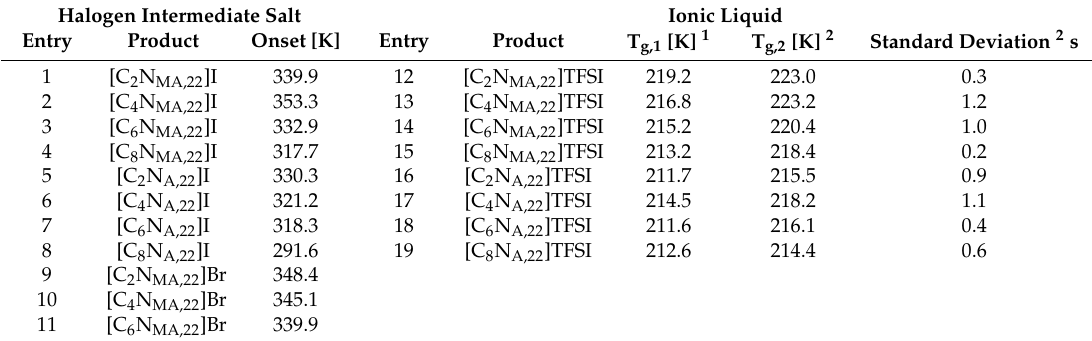
Table 4. Melting points ( T m ) and glass transition temperatures ( T g ) of the products. Standard uncertainties u for values from this work are u ( T m ) = 2 K; u ( T g ) = 2